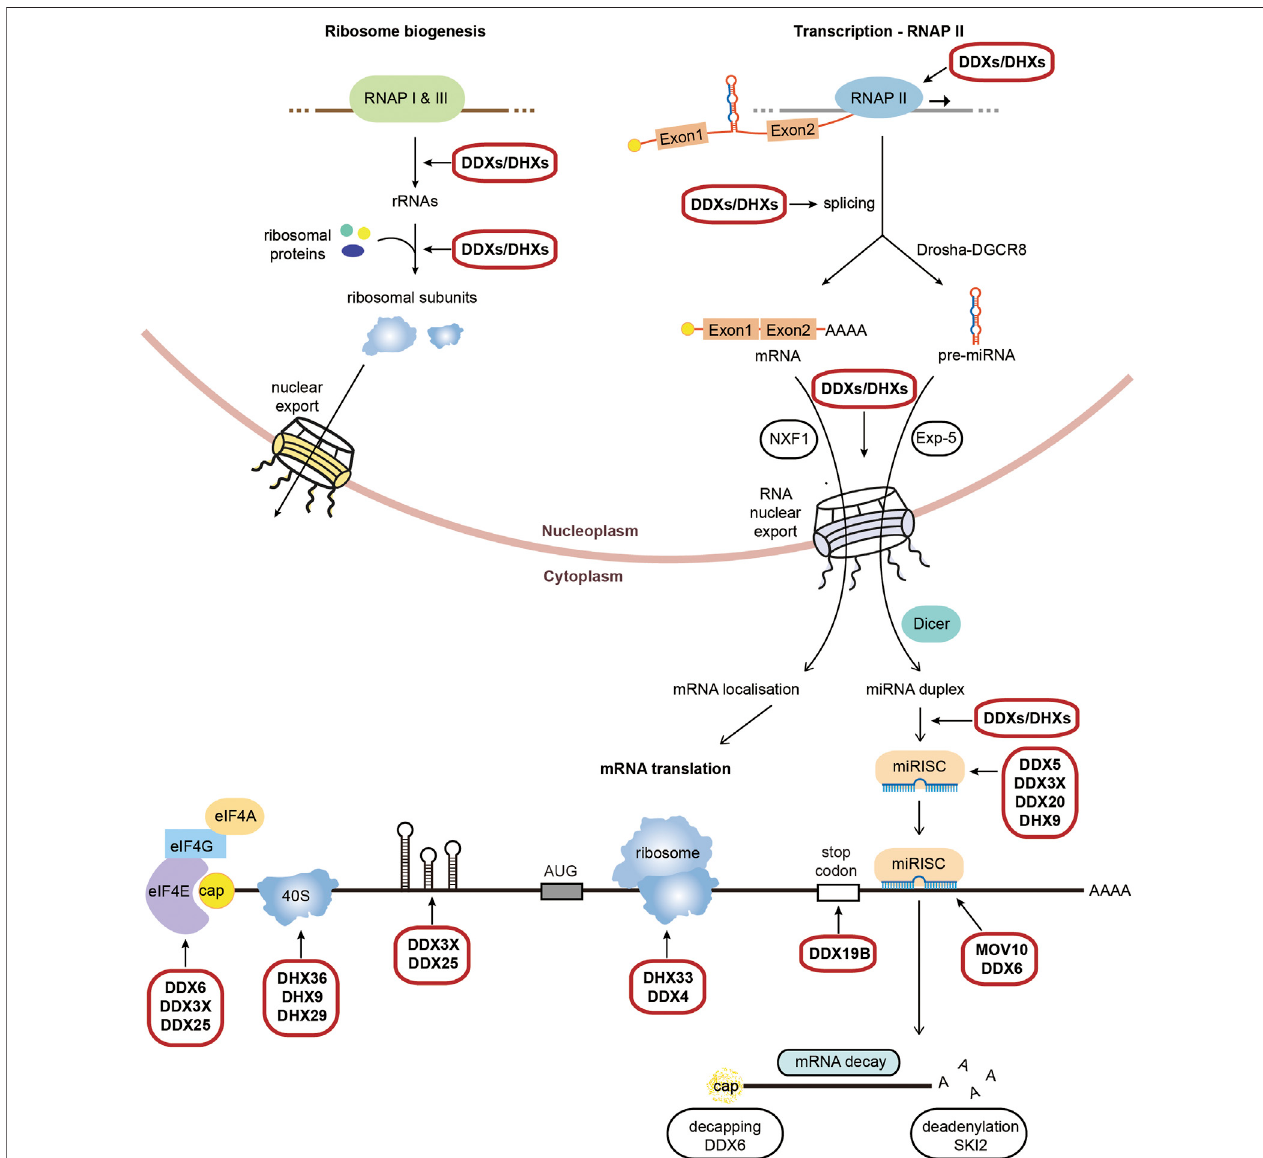
FIGURE1 | Physiological roles ofRNA helicases in mammaliangene expression. Schematic representation of RNAhelicases (DDXs/ DHXs) which function across RNAmetabolic processes from transcription totranslation and decay. Highlighted are the processes which require RNAhelicases tounwind secondary structures, with an emphasis on the process of translation. We refer to Supplementary Table S1 for a detailed list and roles of RNA helicases in the different steps of gene expression.